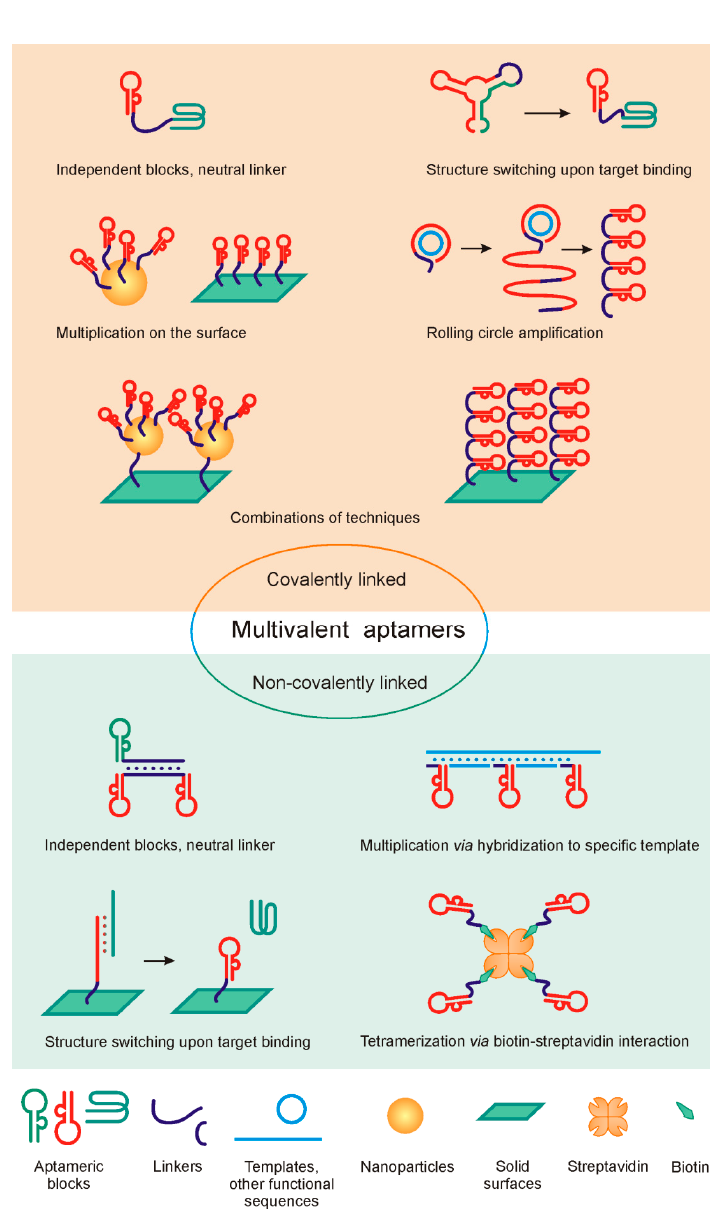
Figure 1. Schematic summary of approaches to multivalent aptamers design.